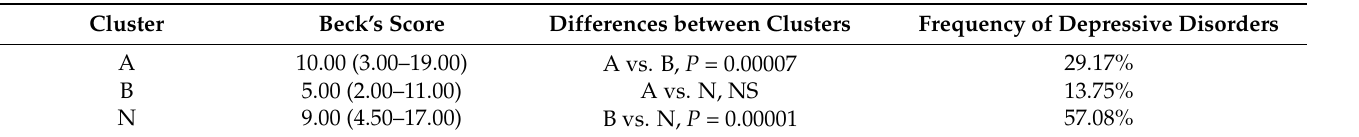
Table 4. Differences in scoring according to Beck’s scale (median and interquartile range) in identified clusters and differences between them. Additionally, the prevalence of depressive disorders in identified clusters was reported ( ≥ 14 points on the Beck’s scale was assumed as the cut-off value).